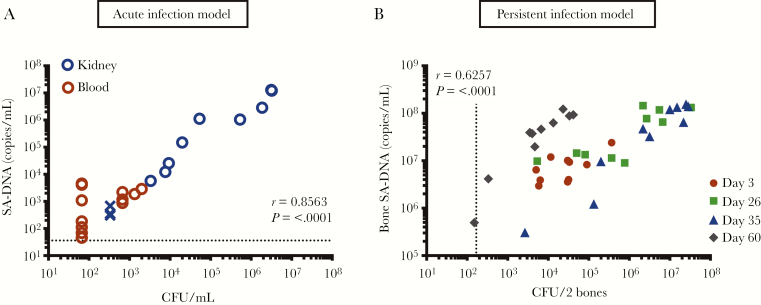
(A) Correlation of agar culture colony-forming unit (CFU) count with Staphylococcus aureus deoxyribonucleic acid (SA-DNA) quantitative polymerase chain reaction (qPCR) copies/mL in acute and persistent infection mouse models. Spearman correlation of culture CFU with relative qPCR counts in kidneys and blood samples from mouse acute infection model and (B) bone samples from persistent mouse infection model. Each symbol represents the counts from an individual infected animal. X symbols indicate no colonies were detected, and all samples were detected by qPCR. Limit of detection 333 CFU/kidney, 167 CFU/2 bones, 67 CFU/mL for blood, and 36 copies/mL for SA-DNA qPCR assay.